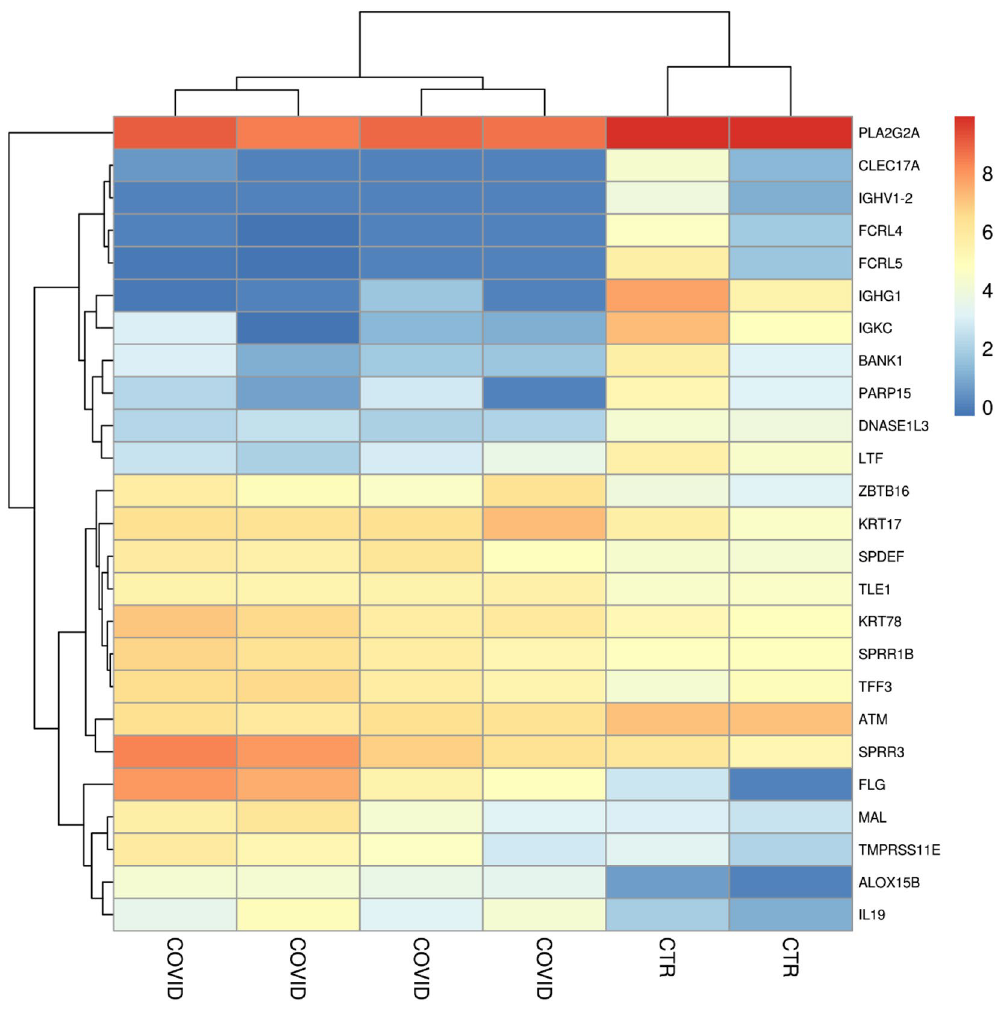
Figure 1. Heatmap of the differentially expressed genes between all the individuals. The heatmap represent the genes differentially expressed after the RNA-seq analysis was concluded. Moreover, the logarithmic correction made on the counts allows to appreciate the differences between the samples. As expected, the dendogram on the columns shows the closest similarity between the healthy subjects each other (CTR) and between the COVID-19 patients themselves (COVID).